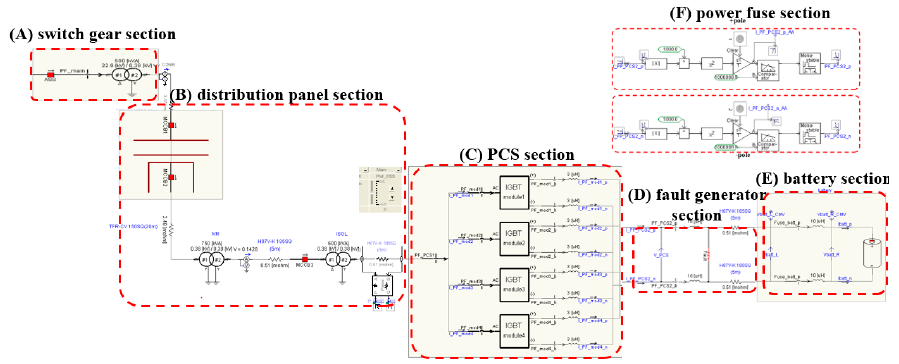
Figure 12. Modeling of Power Receiving System.